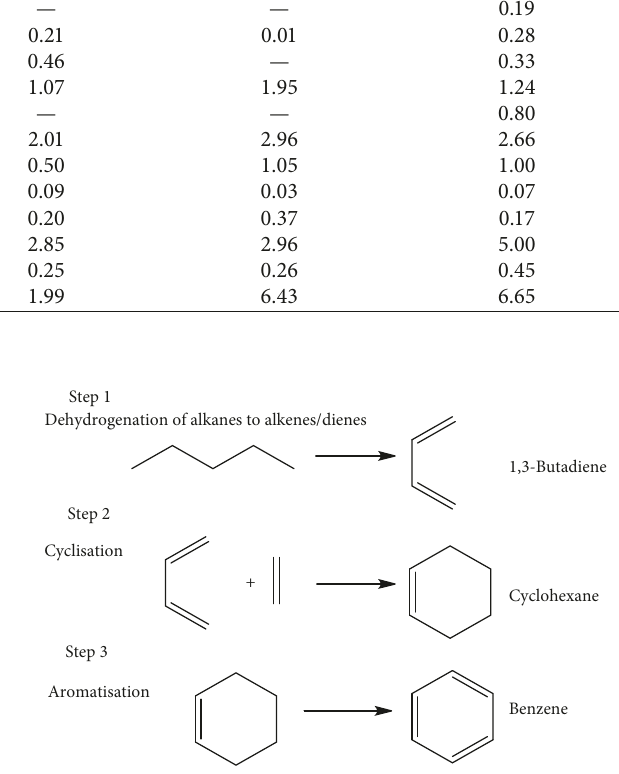
Figure 5: Diels-Alder reaction pathway for formation of the benzene ring [53, 54].